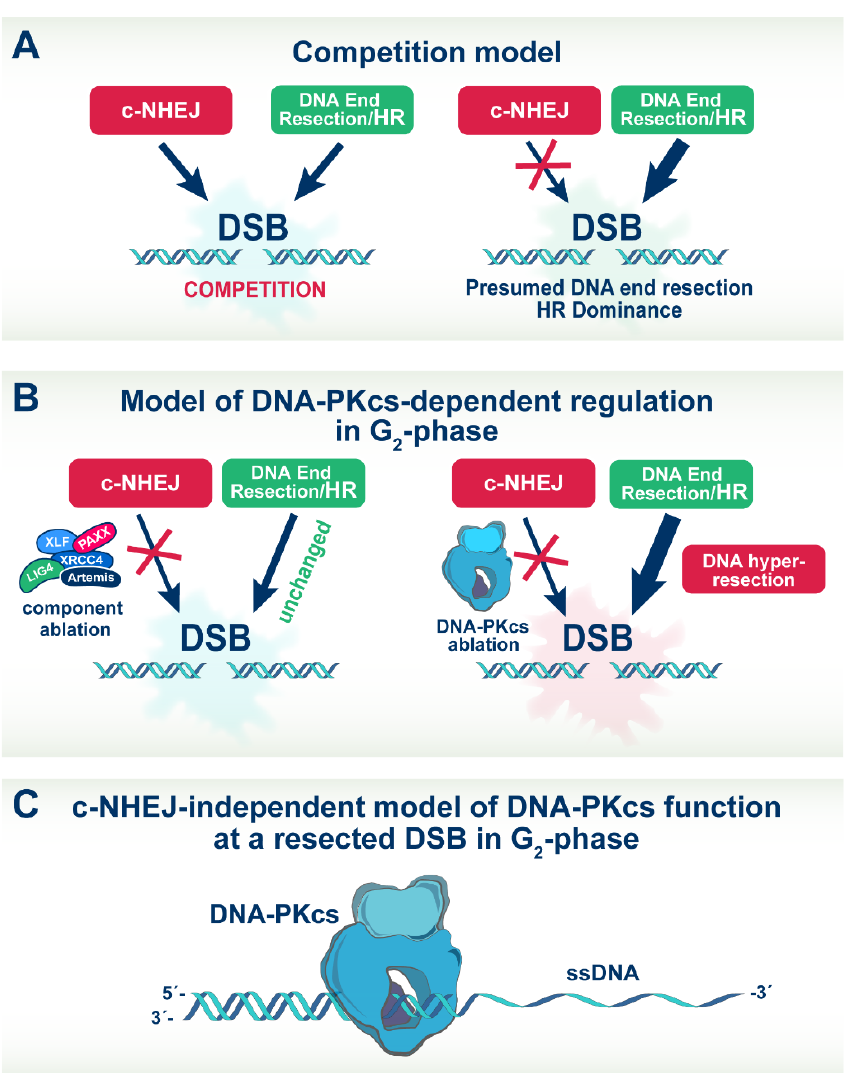
Figure 7. Models of DNA-PKcs function in DSBs repair pathway choice. Model ( A ): It is commonly assumed that choice between c-NHEJ and HR is the outcome of competition at the DSBs, at a first-come first-serve basis; Model ( B ): Our results allow us to modify model A by showing that DNA-PKcs uniquely contributes to resection, in ways that are not shared by other c-NHEJ factors, its ablation causes, therefore, hyper-resection; Model ( C ): A speculative function of DNA-PKcs in the regulation of DSB repair. Our results are compatible with DNA-PKcs remaining at the DSB site, possibly translocating inwards to promote resection. This model might be more relevant for low DSBs loads. For details see